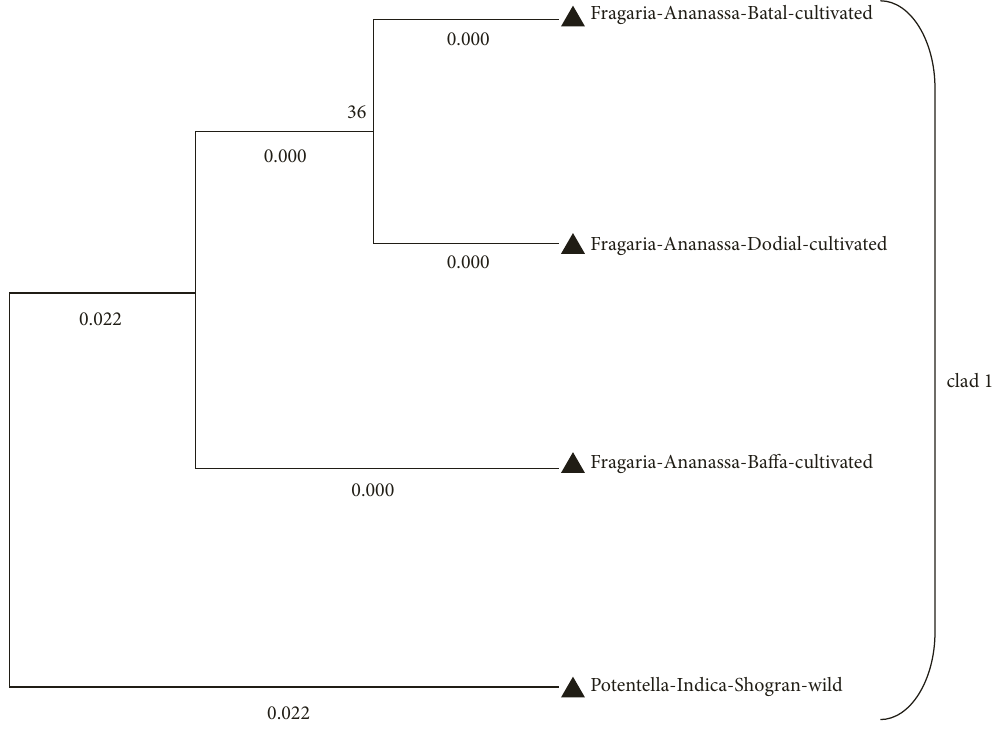
Figure 9: Phylogenetic tree of current Fragaria species sequences of rbclC through the neighbor-joining